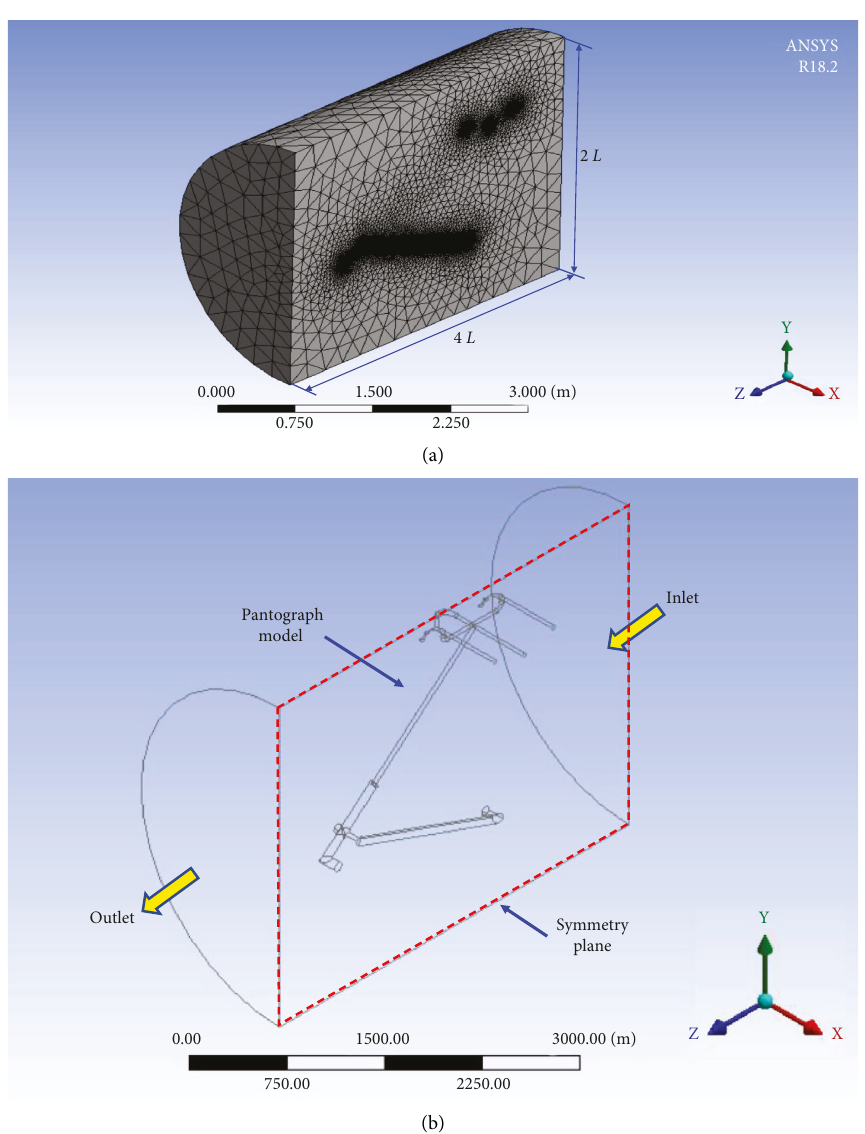
Figure 3: Proposed computational domain for a symmetric model of the pantograph.